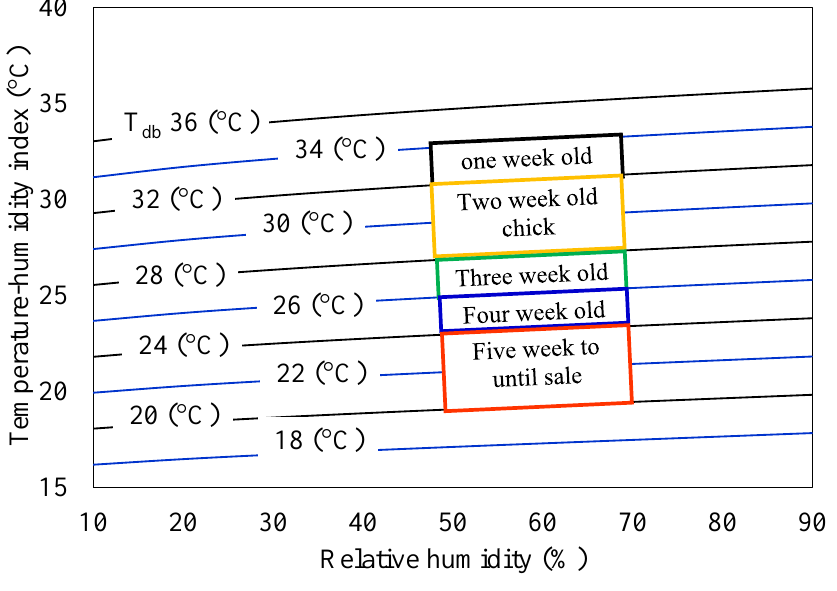
Figure 9. The optimum thermal comfort requirements of the poultry birds of different ages.